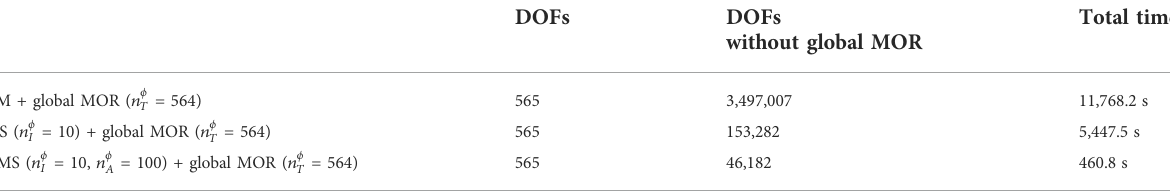
TABLE 4 Overview of FOM, BMS and GBMS UC based fi nite LRM plate model sizes for the clamped fi nite plate assembly of 15 × 15 UCs and total computational times required to calculate the forced vibration responses of Figure